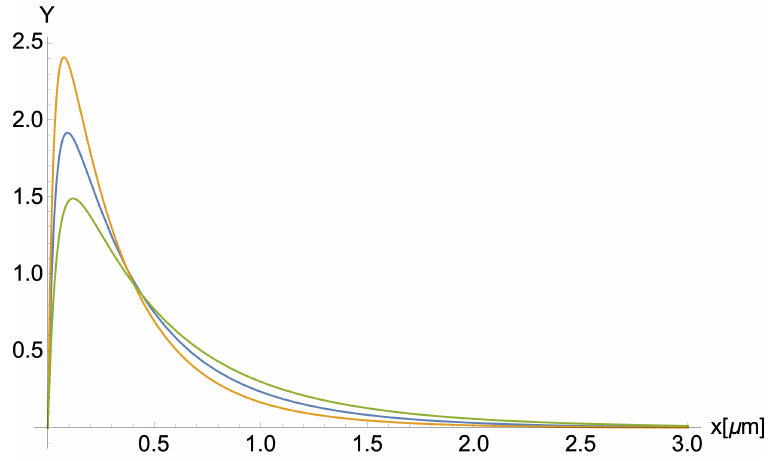
Figure 7. Filament length distribution Y ( λ + , λ − , L ) . Blue, orange, and green colors represent buffers #1, #2, and #3